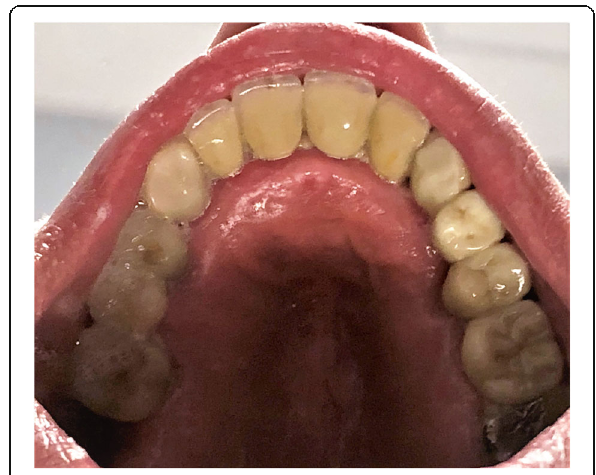
Fig. 7 Post-operative occlusal photograph of the maxilla